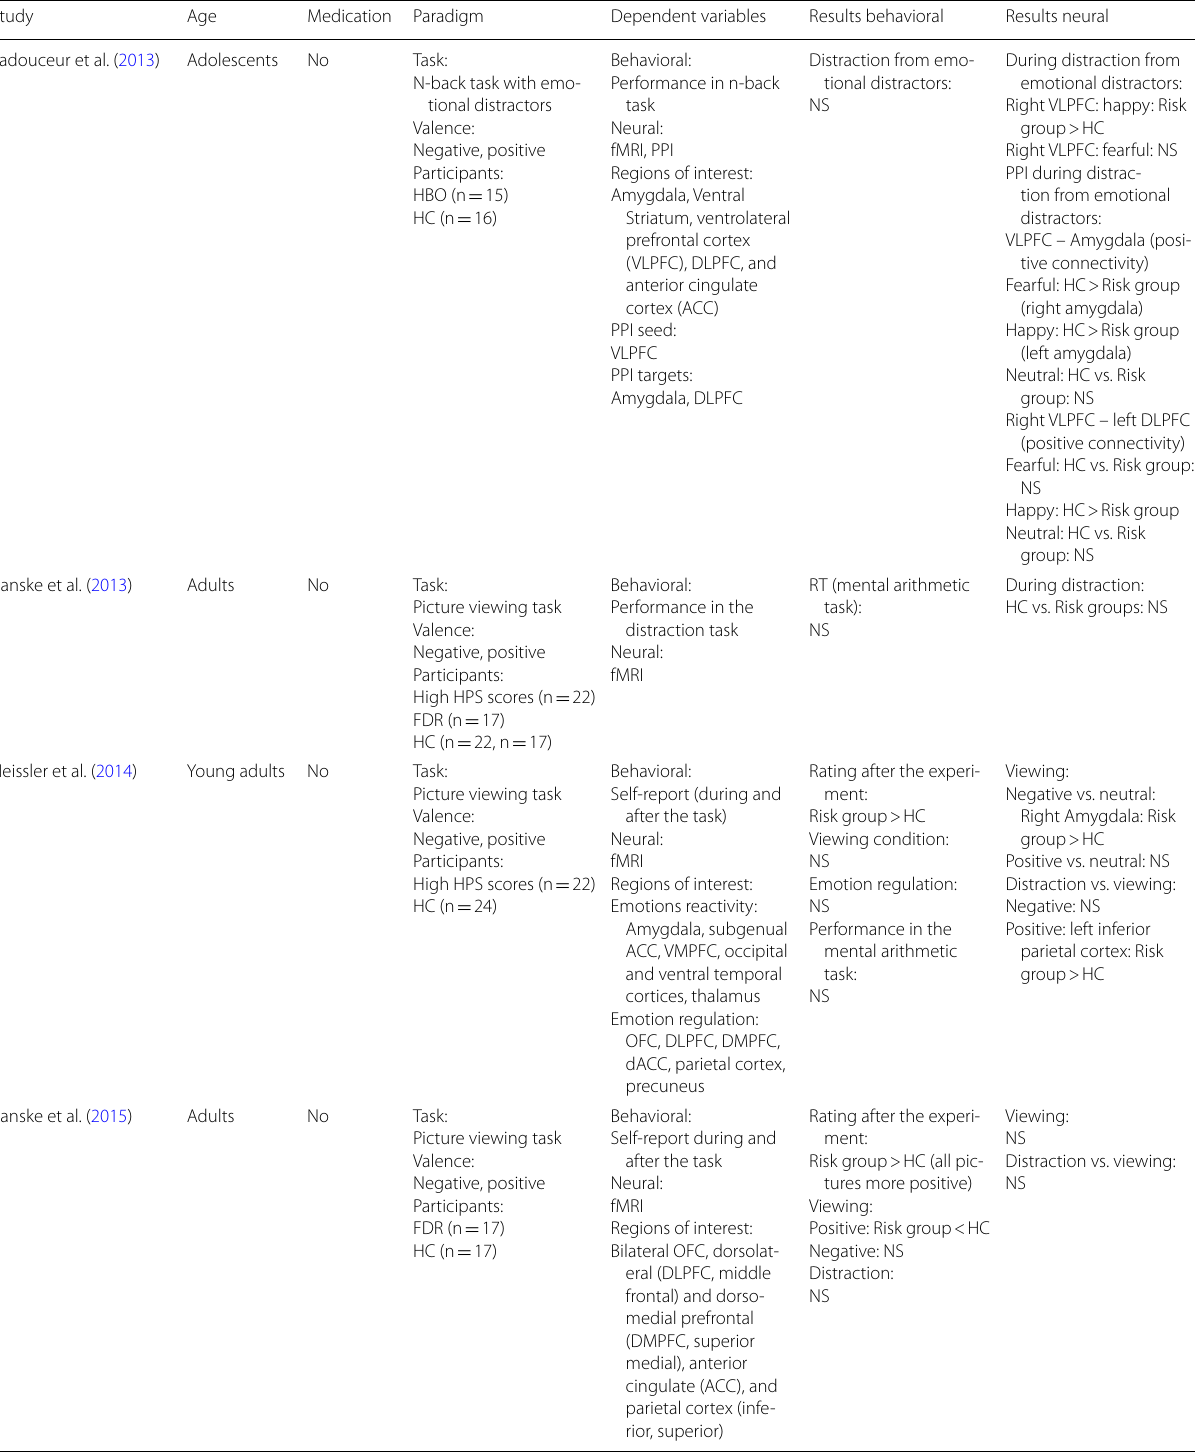
Table 2 Studies that investigated distraction in risk